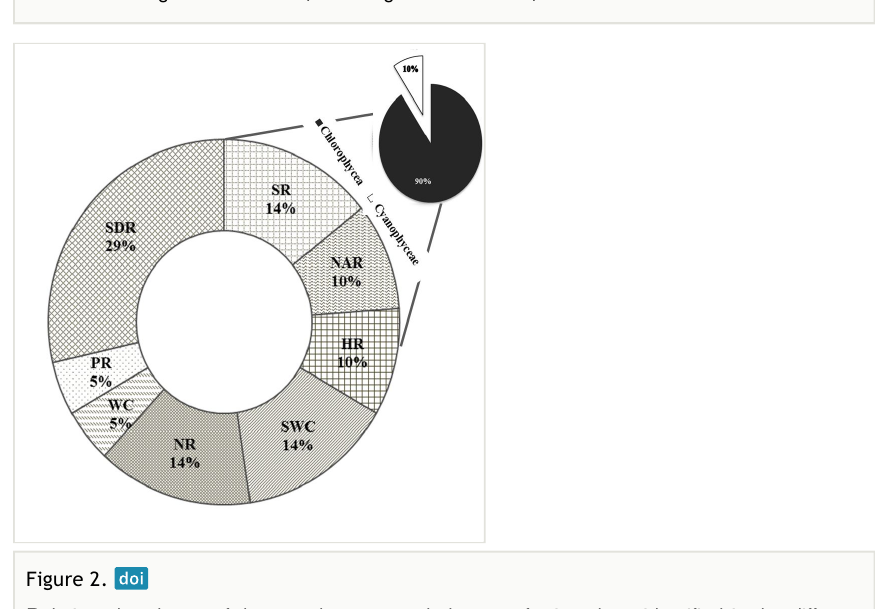
Figure 1. Visual evaluation of the e ffi ciency for isolation in culture media BG11 (a) and CHU (b) from the production of microalgal biomass; Level of concentration is observed with the number of asterisks: ***High concentration; **Average concentration;* Low Concentration.